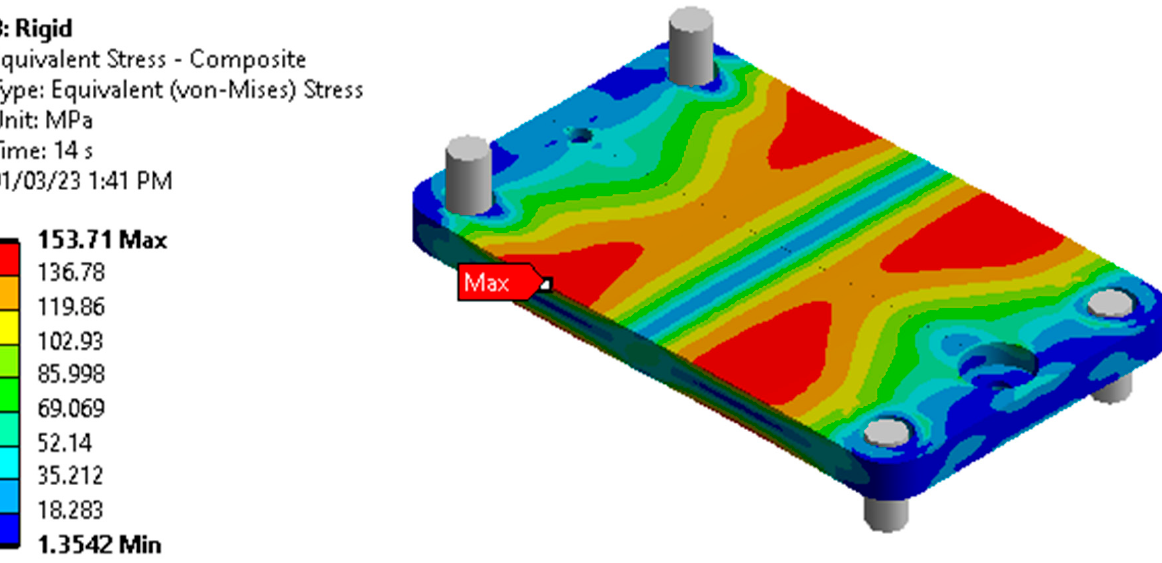
Figure 8. FEA: stress on the elastic element by applying 5000 N axial load.